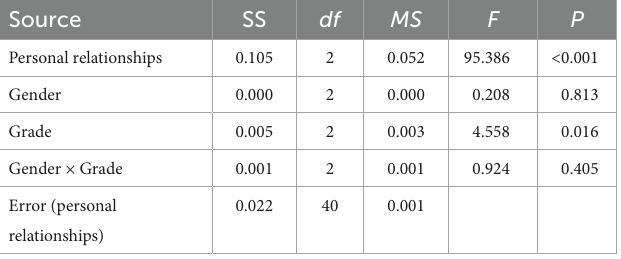
TABLE 4 Results of intra-group factor